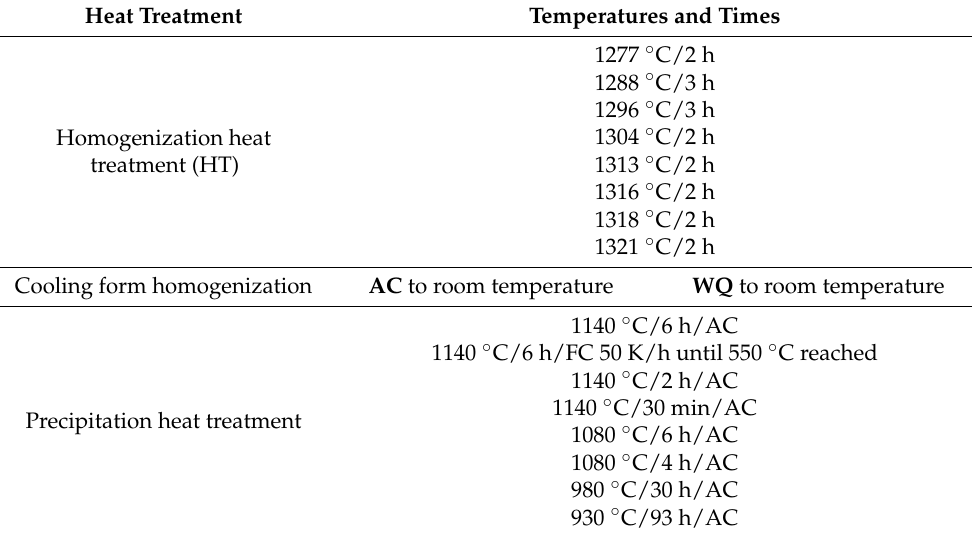
Table 1. Overview of the heat treatment steps and sample designation used in this study. Heat Treatment Temperatures and